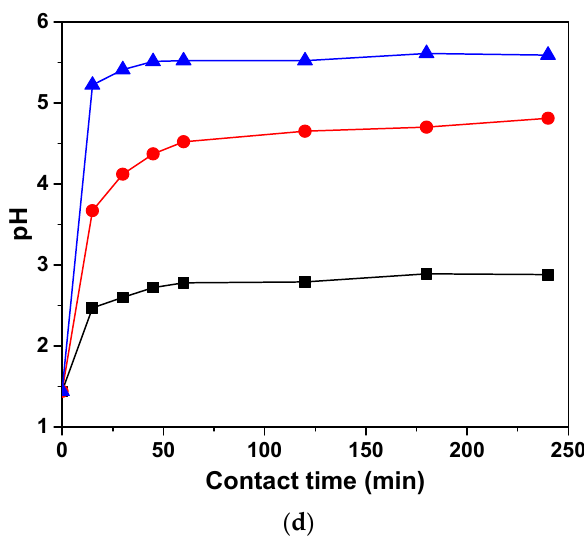
Figure 3. Influence of Cyprinus carpio scale dosage on the residual concentrations of metal ions in AMD solution ( a – c ) and the calculated removal efficiency values ( a ′ – c ′ ) after various contact times. Variation of the pH of AMD solution during the contact time with various dosages of fish scales ( d ). Fish scale dosage: ( ■ ) 0.5 g; ( ● ) 1 g and ( ▲ ) 2 g.